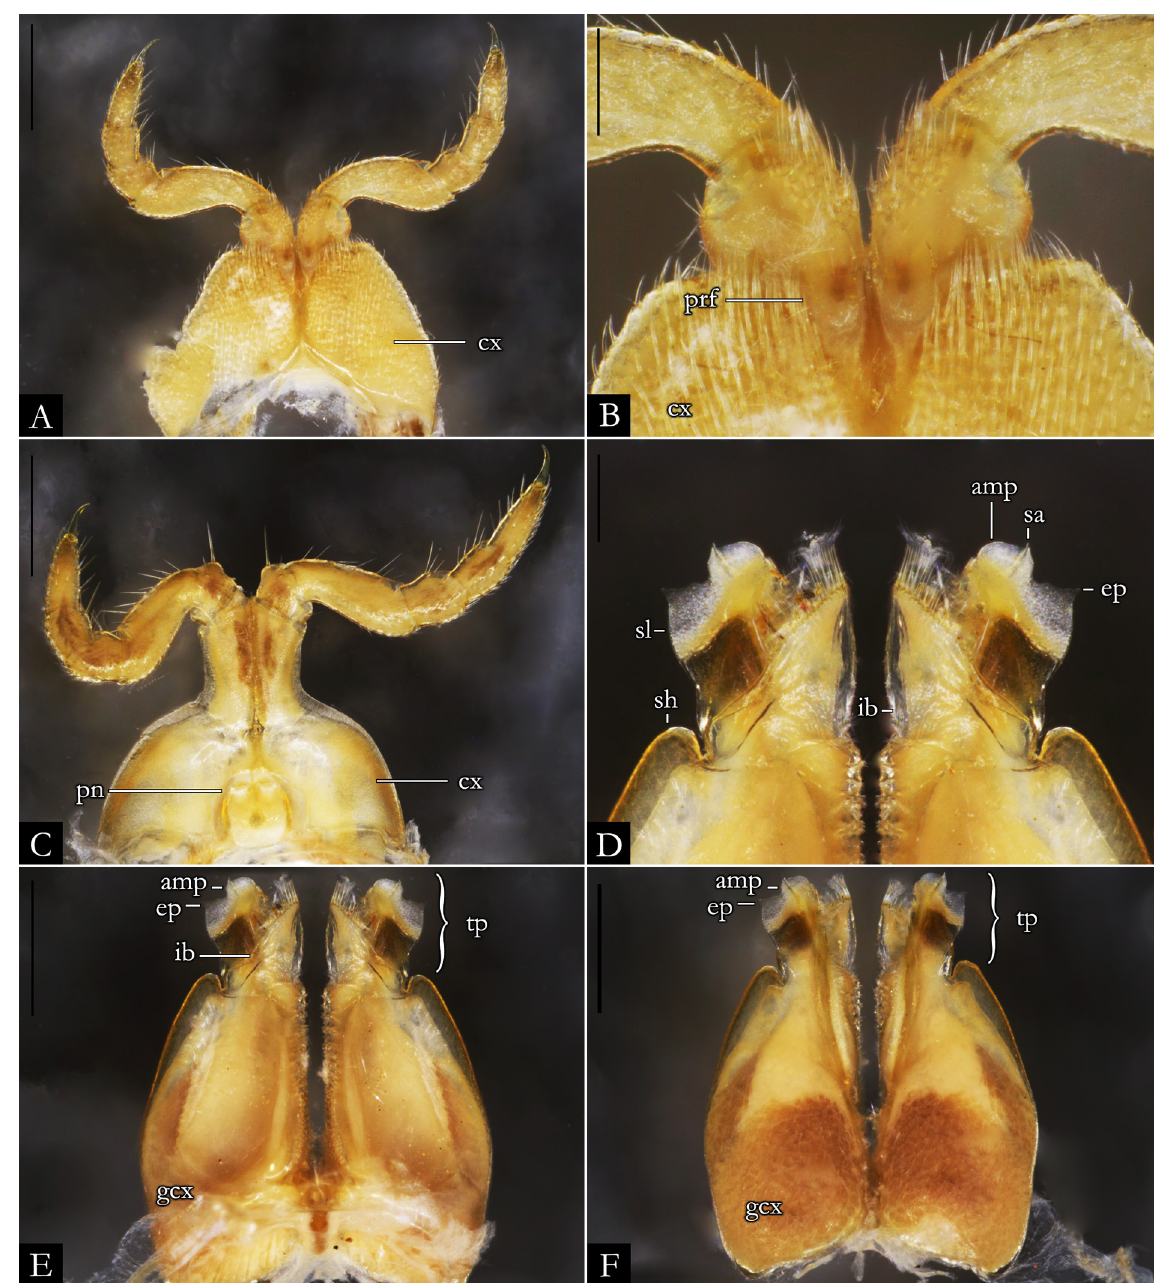
Fig. 77. Pseudonannolene leopoldoi Iniesta & Ferreira, 2014, paratype, ♂ (ISLA 4125). A . First leg-pair. B . Detail of prefemur. C . Second leg-pair. D . Detail of telopodites, in anal view. E . Gonopods, in anal view. F . Gonopods, in oral view. Abbreviations: see Material and methods. Scale bars: A, E–F = 0.5 mm; B–D = 0.2